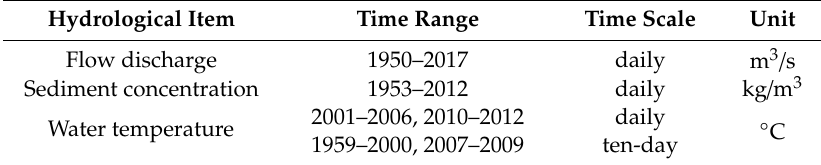
Table 1. Data information during May–June and